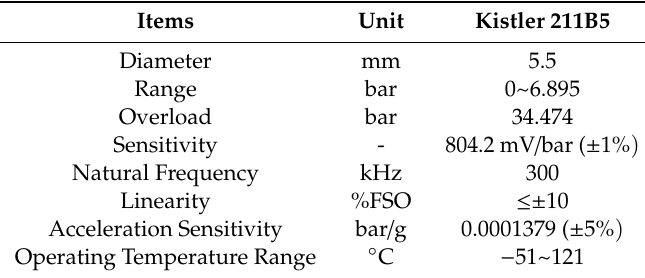
Table 3. Specifications of Pressure Sensor.